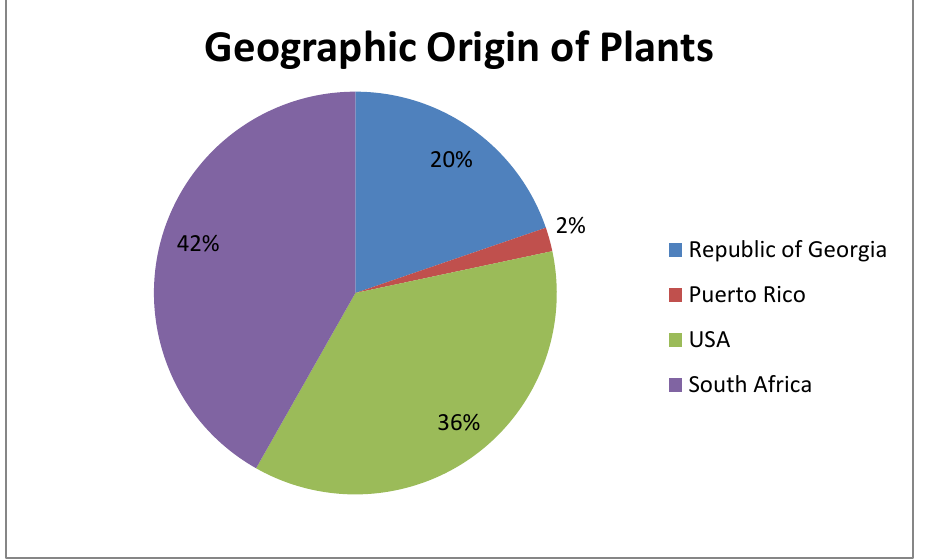
Figure 5. Geographic origin of the plants and respective percentage of use in this study.